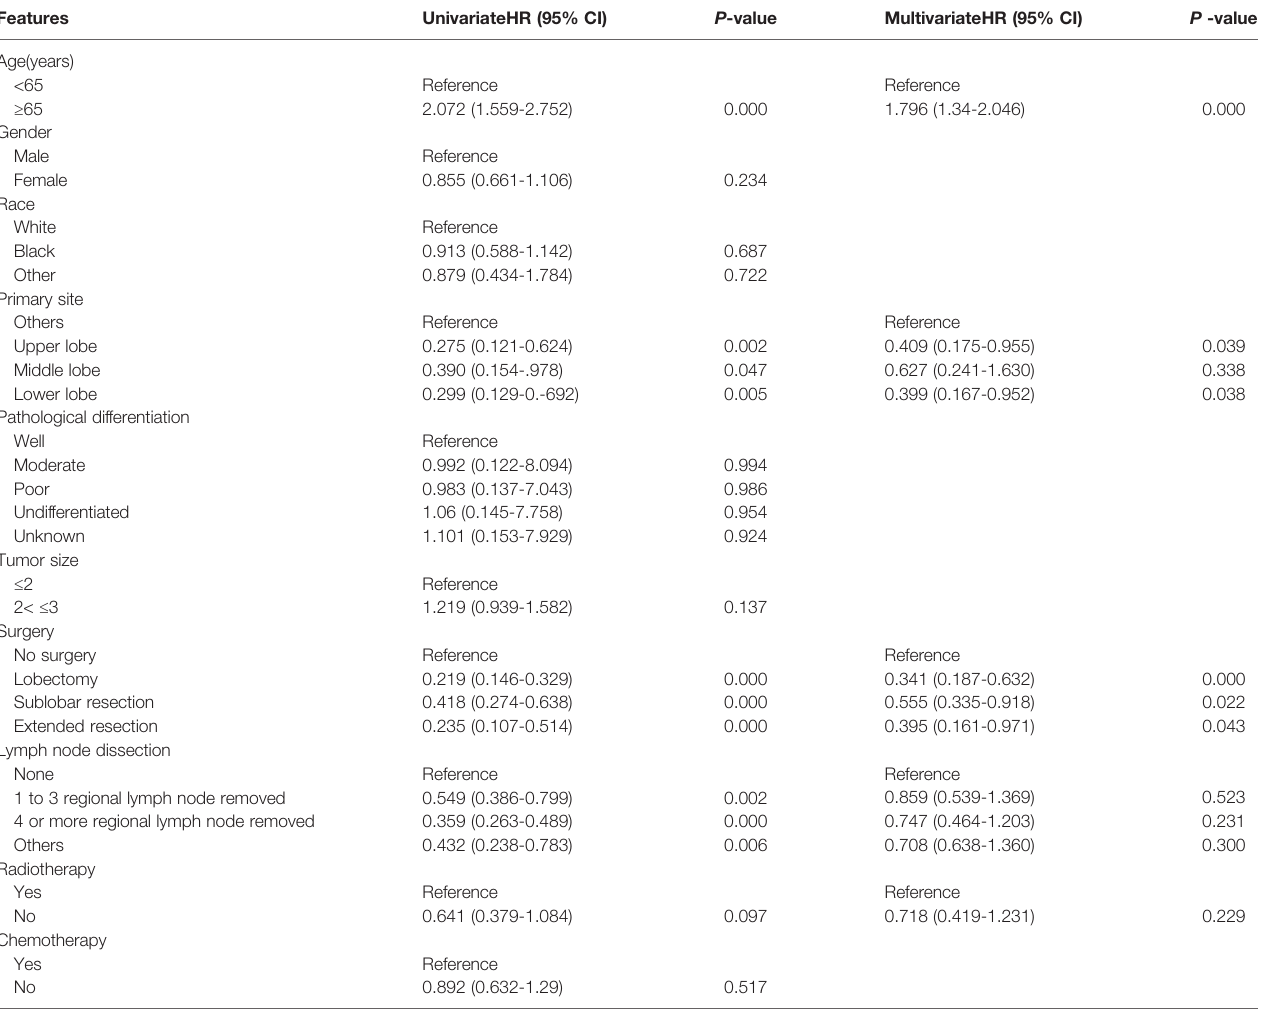
TABLE 3 | Univariate and multivariate Cox regression analysis of prognostic factors in fl uencing survival outcomes. N=381.